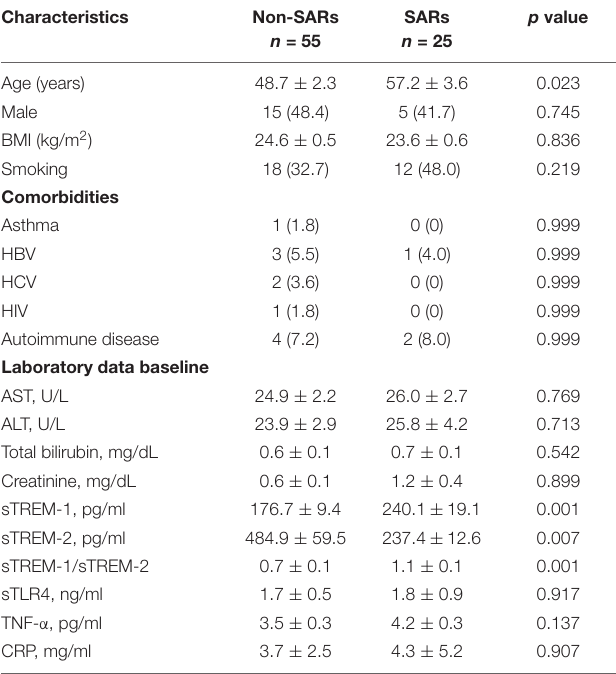
TABLE 1 | Demographic and clinical characteristics of patients. Characteristics